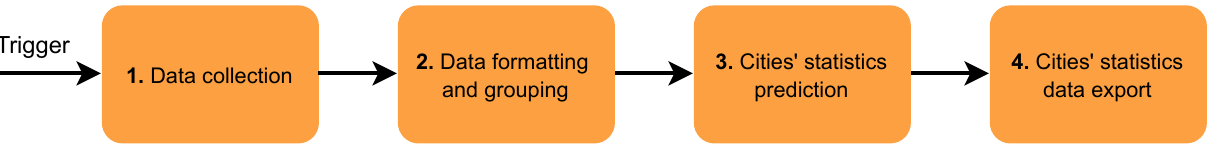
Figure 4. The conceptual diagram of the iBikeSafe statistical data collection